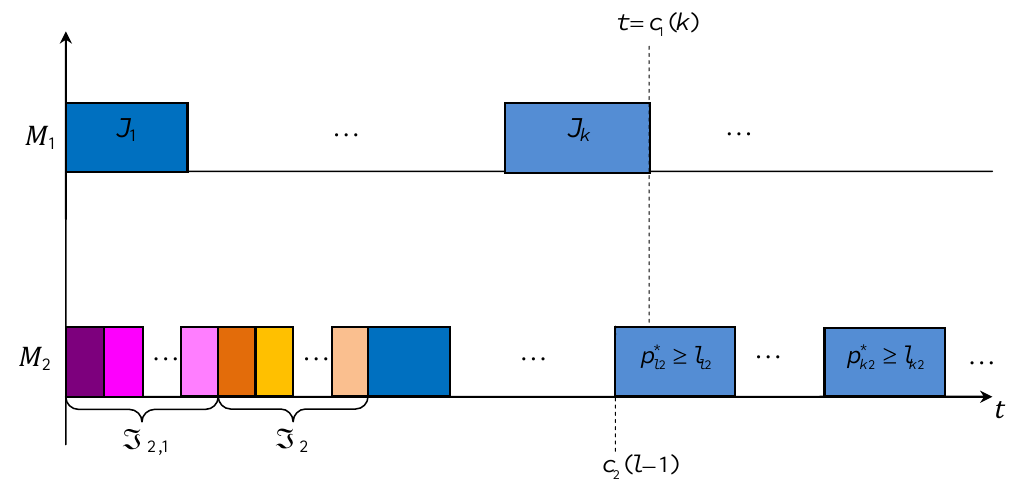
Figure 3. The initial part of the schedule